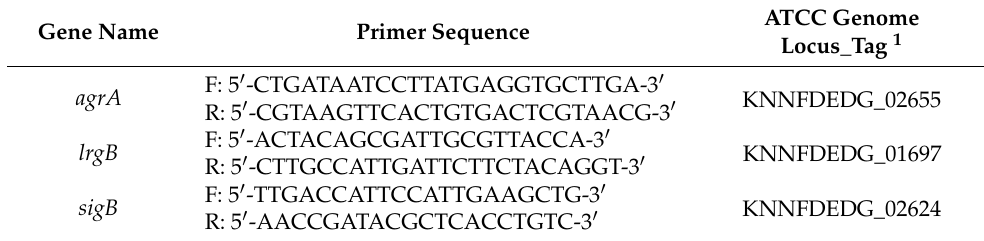
Table 3. Primer sequences required for qRT-PCR